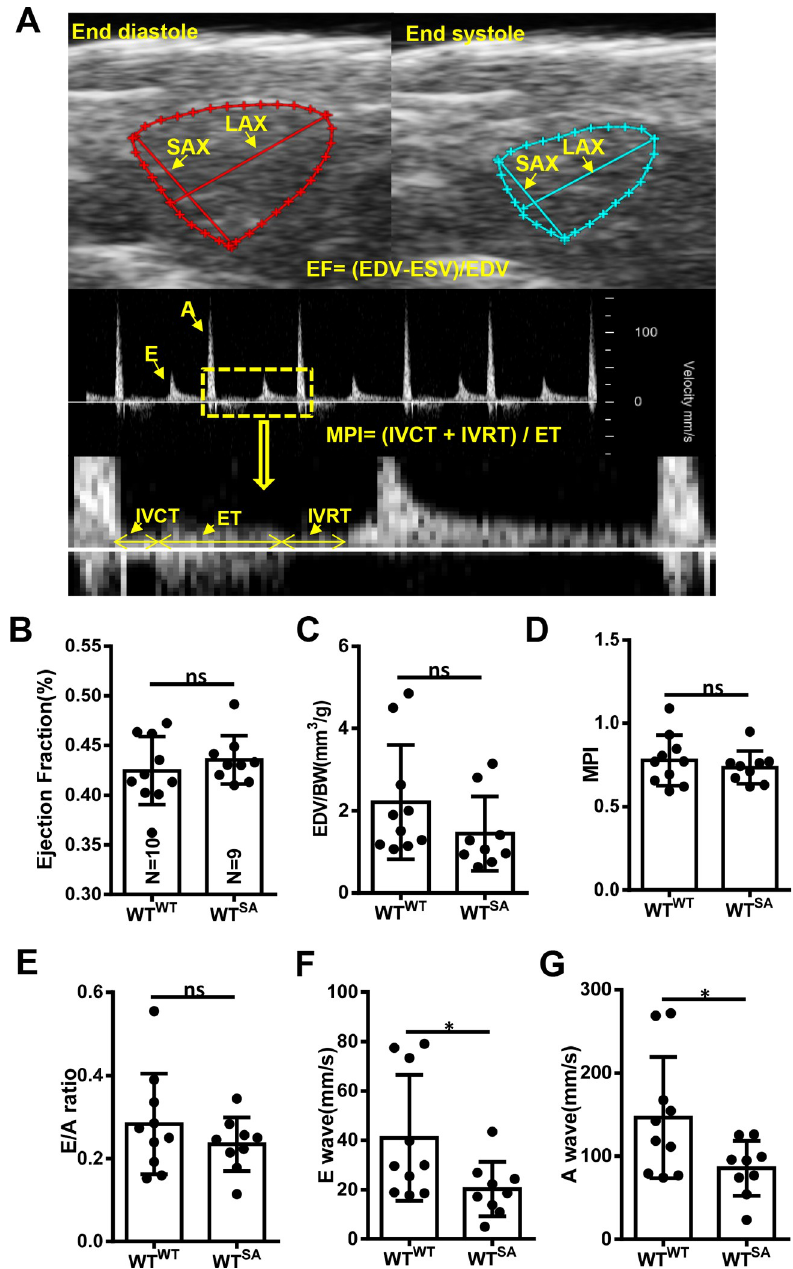
Fig 8. Cardiac function remains unchanged between wild-type fish with (WT SA ) and without (WT Normal ) sinus arrest. A, Representative B mode echocardiogram of a zebrafish heart at end-diastole (top left) and end-systole (top right) and pulsed-wave Doppler images for quantification of E wave, A wave, IVCT, ET, and IVRT. B-G, Quantification of cardiac function indices between WT Normal and WT SA siblings. � P < .05 (Student t test). A indicates peak velocity of late ventricular filling; BW, body weight; E, peak velocity of early ventricular filling; EDV, end-diastolic volume; EF, ejection fraction; ESV, end-systolic volume; ET, ejection time; IVCT, isovolumic contraction time; IVRT, isovolumic relaxation time; LAX, long axis; MPI, myocardial performance index; ns, not significant; SAX, short axis; WT SA , wild-type fish with SA; WT Normal , wild-type fish without SA.